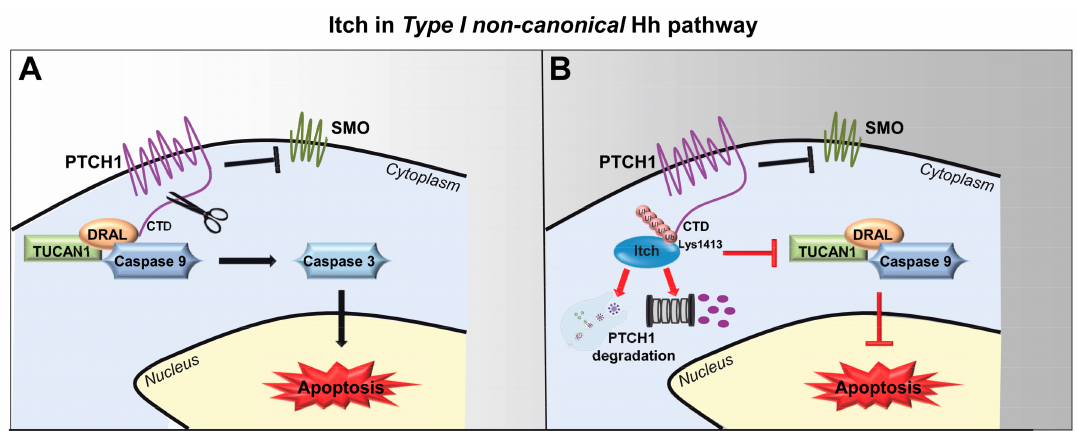
Figure 4. Role of Itch in Type I non-canonical Hh pathway. ( A ) In the absence of Hh, PTCH1 recruits a pro-apoptotic complex, including DRAL, TUCAN1 and Caspase 9, to its C-Terminal Domain (CTD). The activation of the Caspase 9 promotes the cleavage of the PTCH1 CTD by the Caspase 3, leading to irreversible commitment to cell death. ( B ) In the presence of Itch, the Lys1413 at the PTCH1 CTD is ubiquitylated, leading to the internalization and degradation of the PTCH1 and to the impairment of its pro-apoptotic